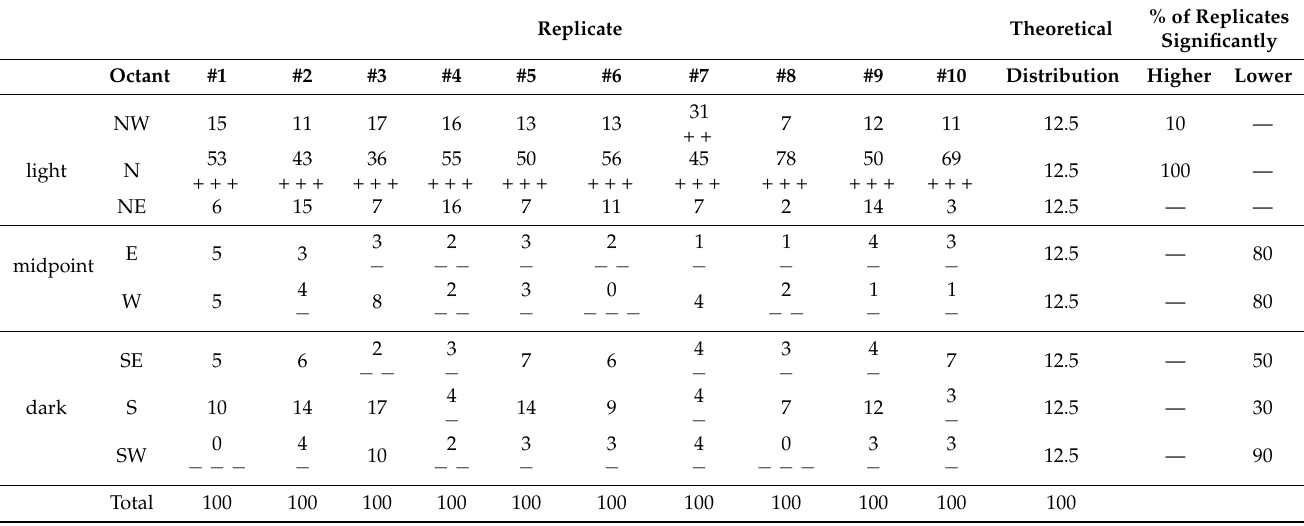
Table 2. Experiment #1. Movements of beetles to octants.